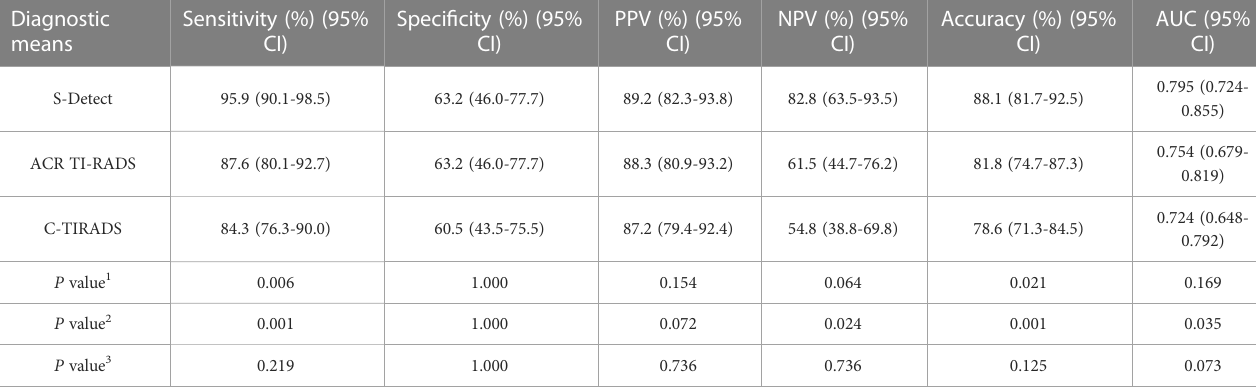
TABLE 7 Comparison of the diagnostic performance of S-Detect and the two TI-RADS classi fi cations. Diagnostic